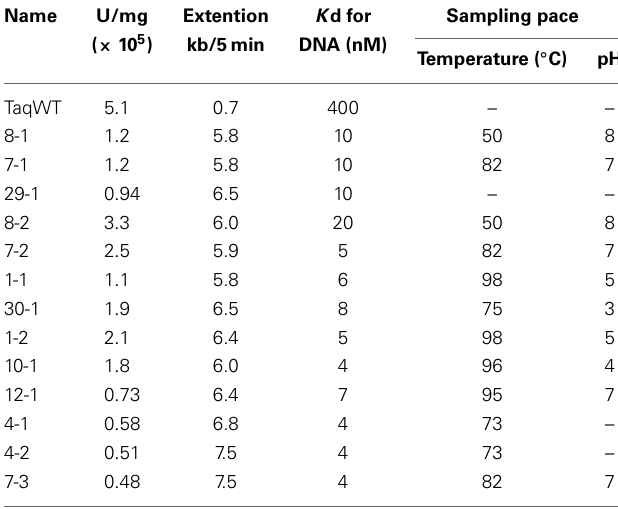
Table 3 | Properties of the chimeric Taq